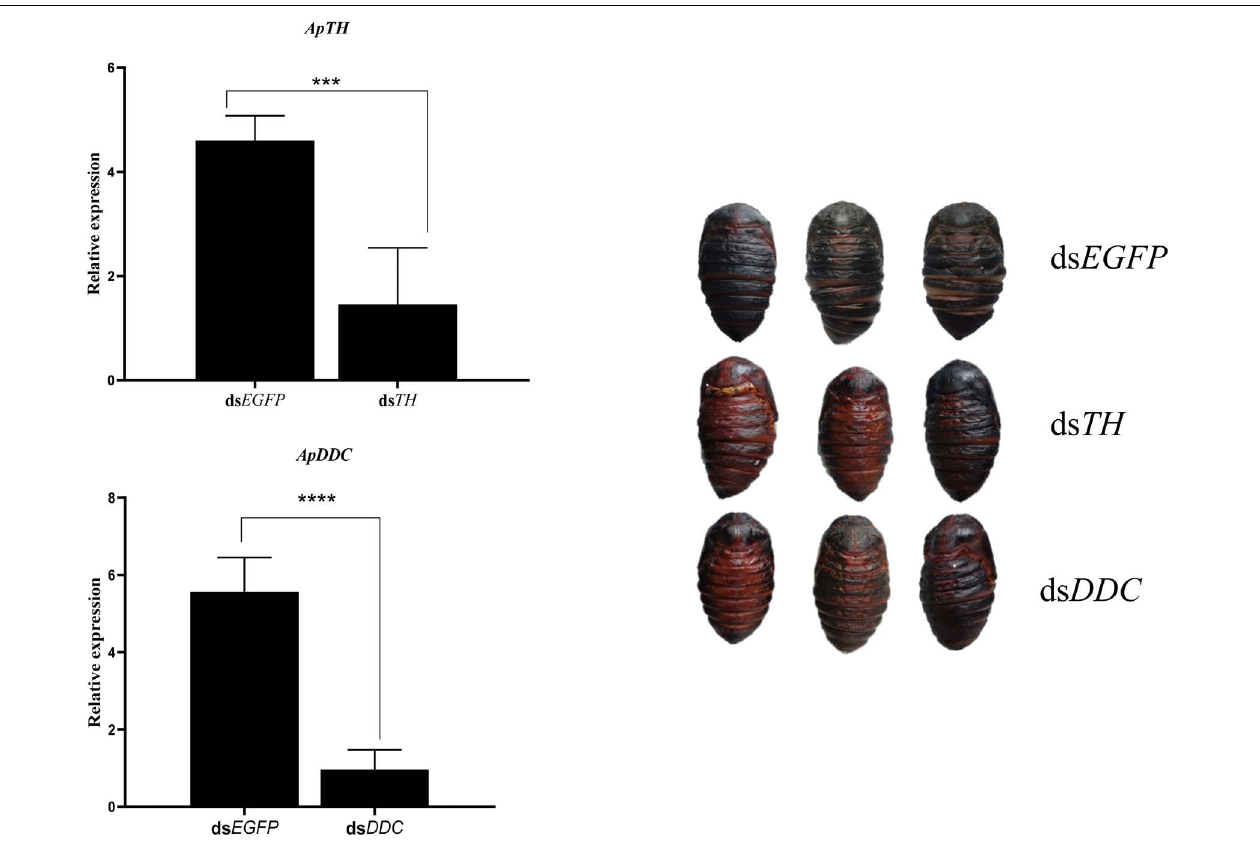
FIGURE 6 | Effects of knockdown of ApTH and ApDDC during the prepupal stage and the corresponding morphological changes. A significant difference was observed using Student’s t test. *** p < 0.001, **** p < 0.0001. TABLE 2 | Statistics of pupae obtained after injecting pre-pupae of A. pernyi with TH and DDC inhibitors. Inhibitors Concentration